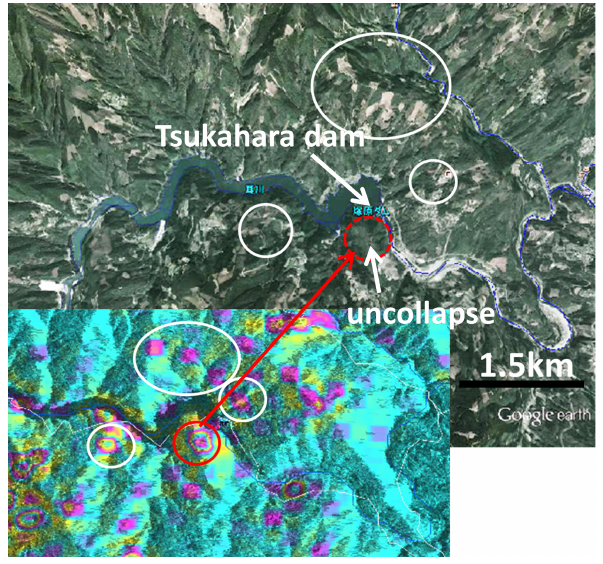
Figure 6. Uncollapsed zone to the south of Tsukahara dam was ex- tracted from descending PALSAR image. (Base map is from Google